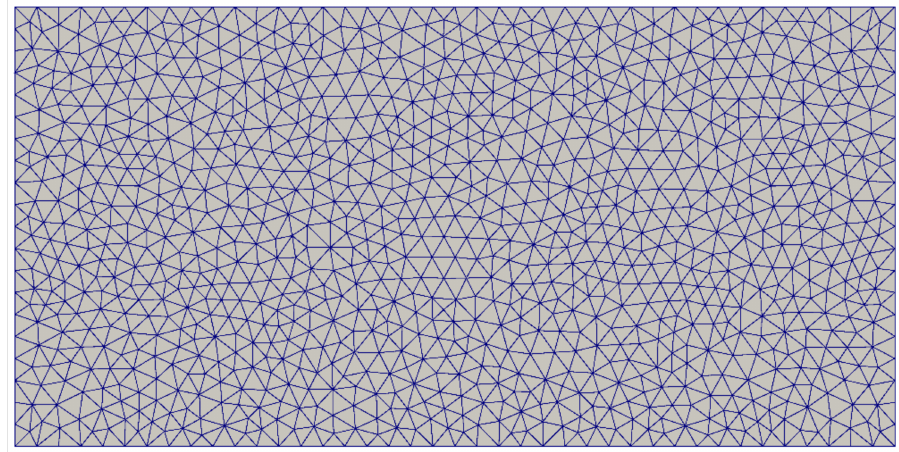
Figure 1. Sample mesh of a rectangular